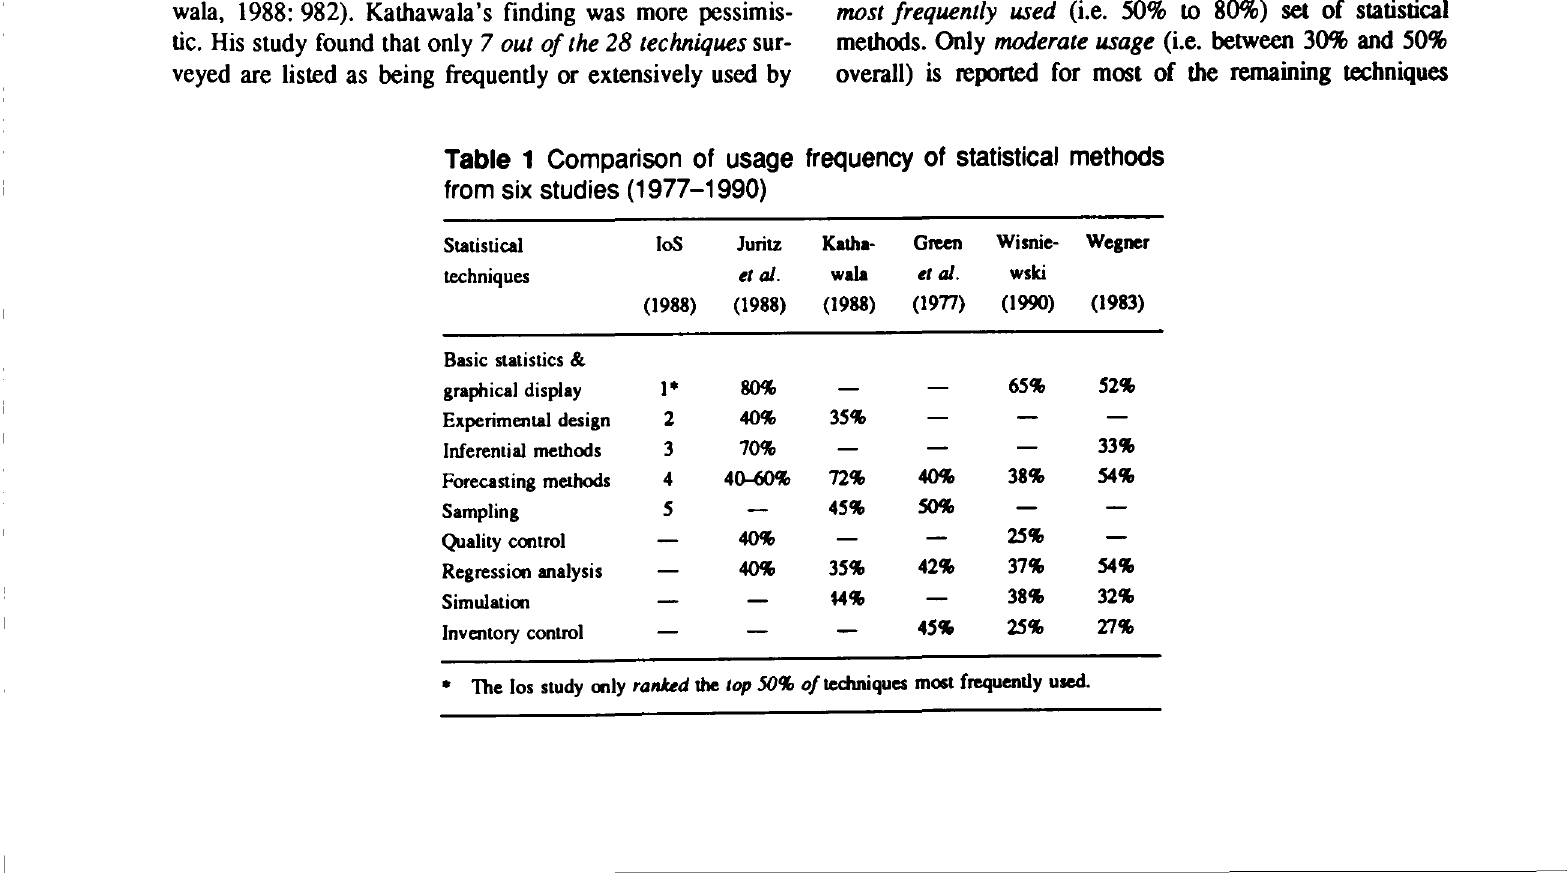
Table 1 Comparison of usage frequency of statistical